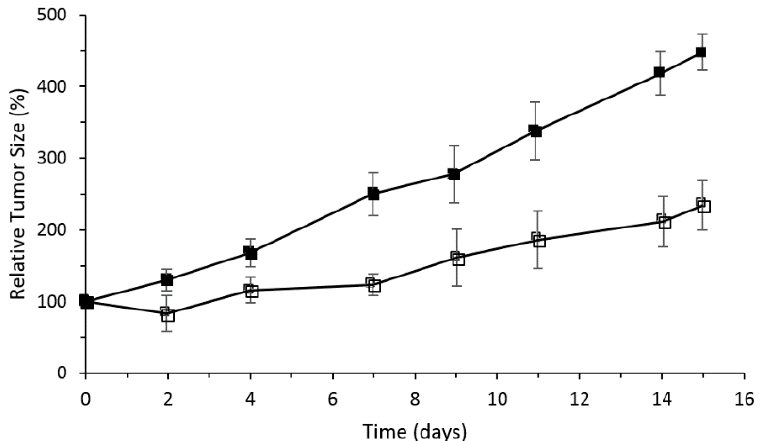
Figure 24. Tumor growth delay after PDT treatment with PMe- β -CD-hexyl-Si IV Pc under illumination ( λ = 635 nm, 30 J/cm 2 ) ( □ ) and mice kept in darkness for control ( ■ ). Adapted from Lau; Lo; Fong; Ng [142].